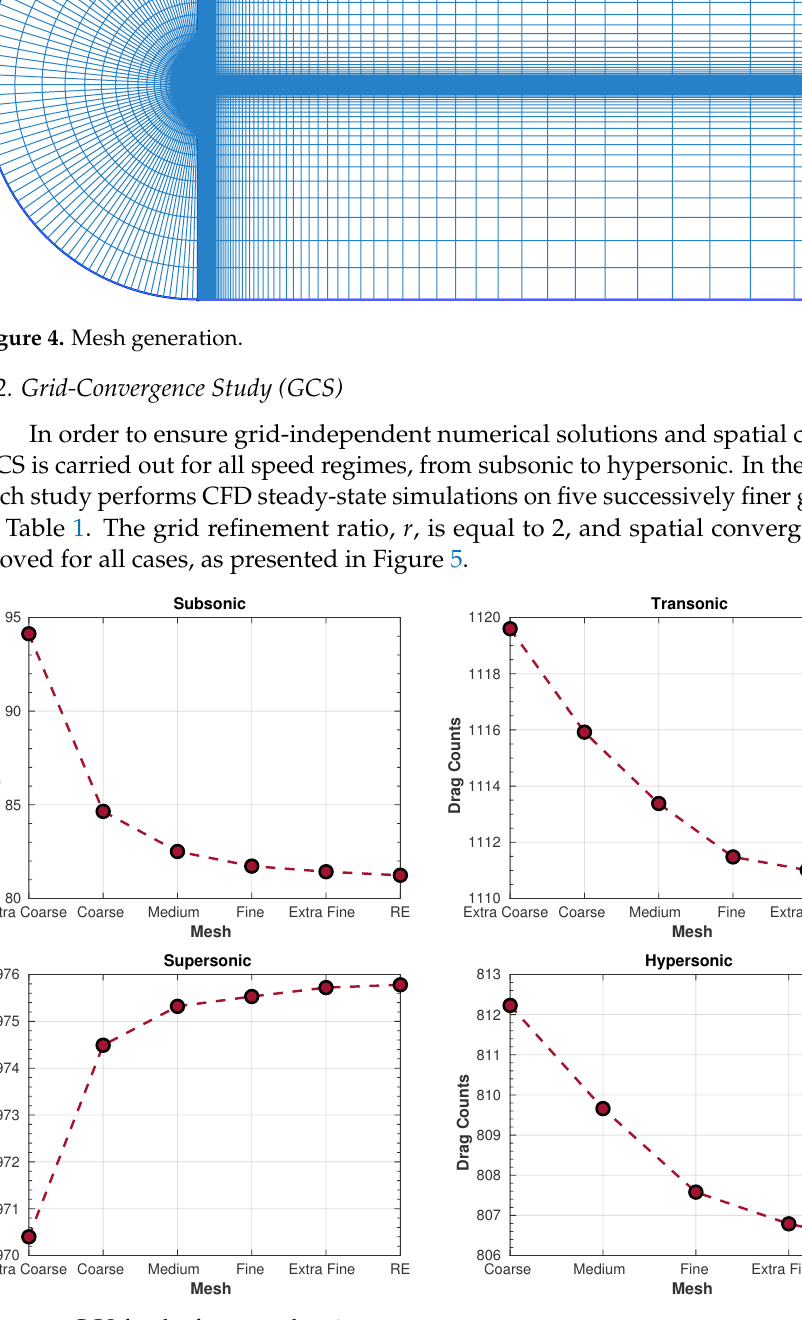
Figure 5. GCS for the four speed